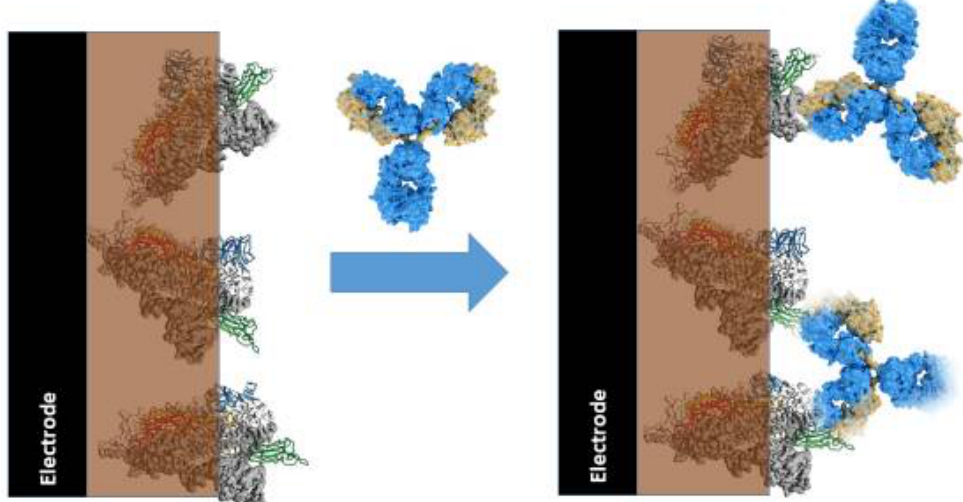
Figure 4. Action of immunosensor based on antigens (e.g., virus nucleocapside proteins) immobilized within conducting polymer, polypyrrole, and the formation of the immune complex between immobilized protein (e.g., virus proteins) and antibodies against these proteins, which are present in the dissolved aliquot.